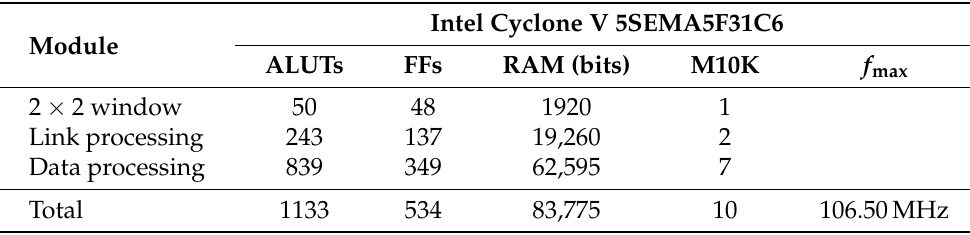
Table 1. Synthesis results using ‘balanced’ optimisation, for a 1920 × 1080 image, extracting the bounding box and area of each connected component. ALUTs are Intel’s adaptive lookup tables; FFs are the number of flip-flops or registers; M10K are the number of Intel’s 10kbit RAM